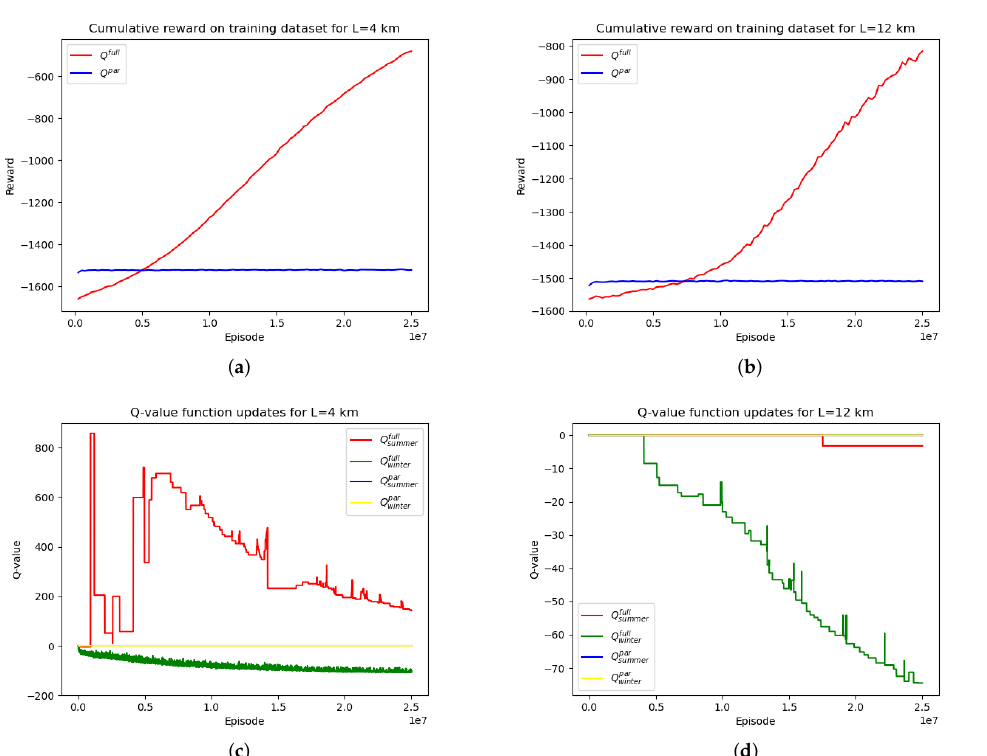
Figure 3. ( a ) Cumulative reward change during training for L “ 4 km. ( b ) Cumulative reward change during training for L “ 12 km. ( c ) Q -value functions Q p s 1 , a 1 q and Q p s 2 , a 2 q updates for L “ 4 km. ( d ) Q -value functions Q p s 1 , a 1 q and Q p s 2 , a 2 q updates for L “ 12 km. Q -value functions for Q par summer (blue line) and Q par (yellow line) are winter